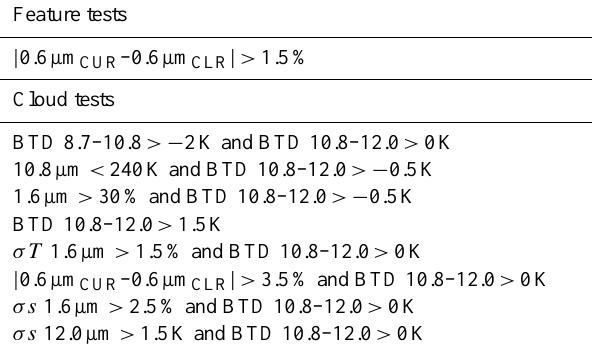
Table 2. Outline of the algorithm applied over land, showing the various thresholds used for the feature tests and cloud